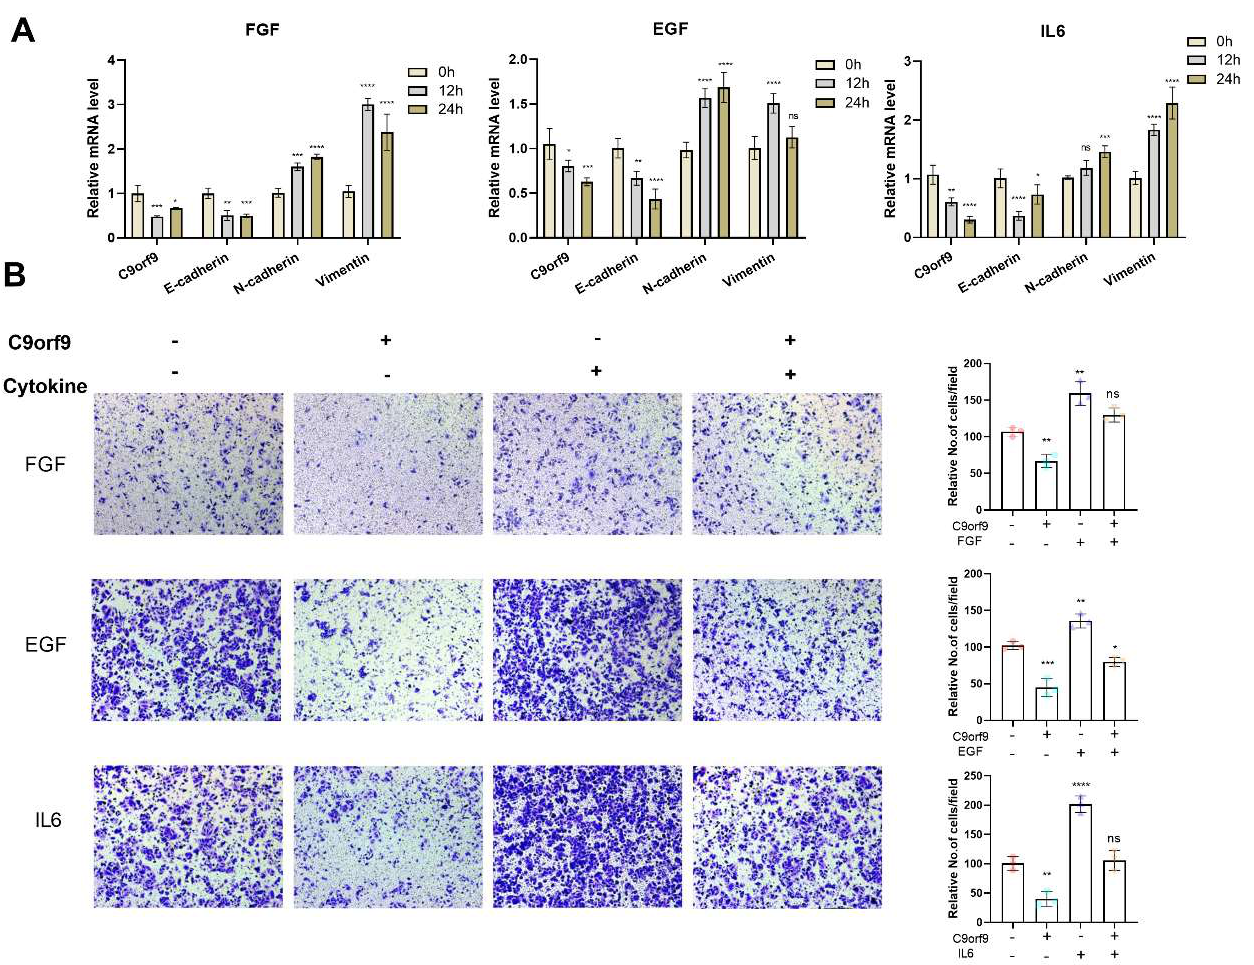
Figure 6. C9orf9 responds to and involves in FGF, EGF, and IL6 induced EMT. ( A ). Q-PCR analysis of C9orf9 and EMT-related markers (E-cadherin, N-cadherin, Vimentin) in FGF (20 ng/mL), EGF (20 ng/mL), and IL6 (50 ng/mL)-stimulated SW480 cells at 0, 12, and 24 h. ( B ) Transwell (Matrigel-free) assays of LV-NC and LV-C9orf9 SW480 cells with or without cytokine stimulation. * p < 0.05, ** p < 0.01, *** p < 0.001, **** p < 0.0001.